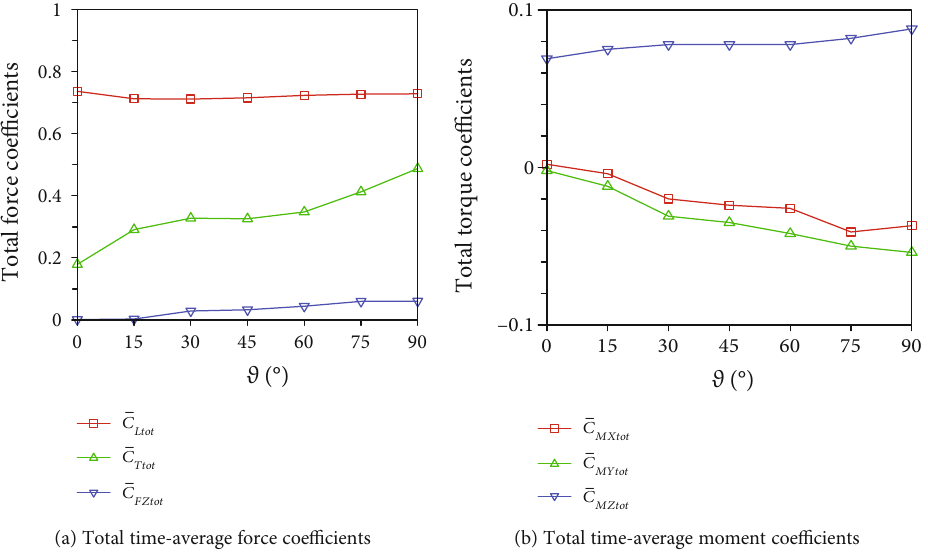
Figure 4: Coe ffi cients of total time-average forces and moments vs ϑ